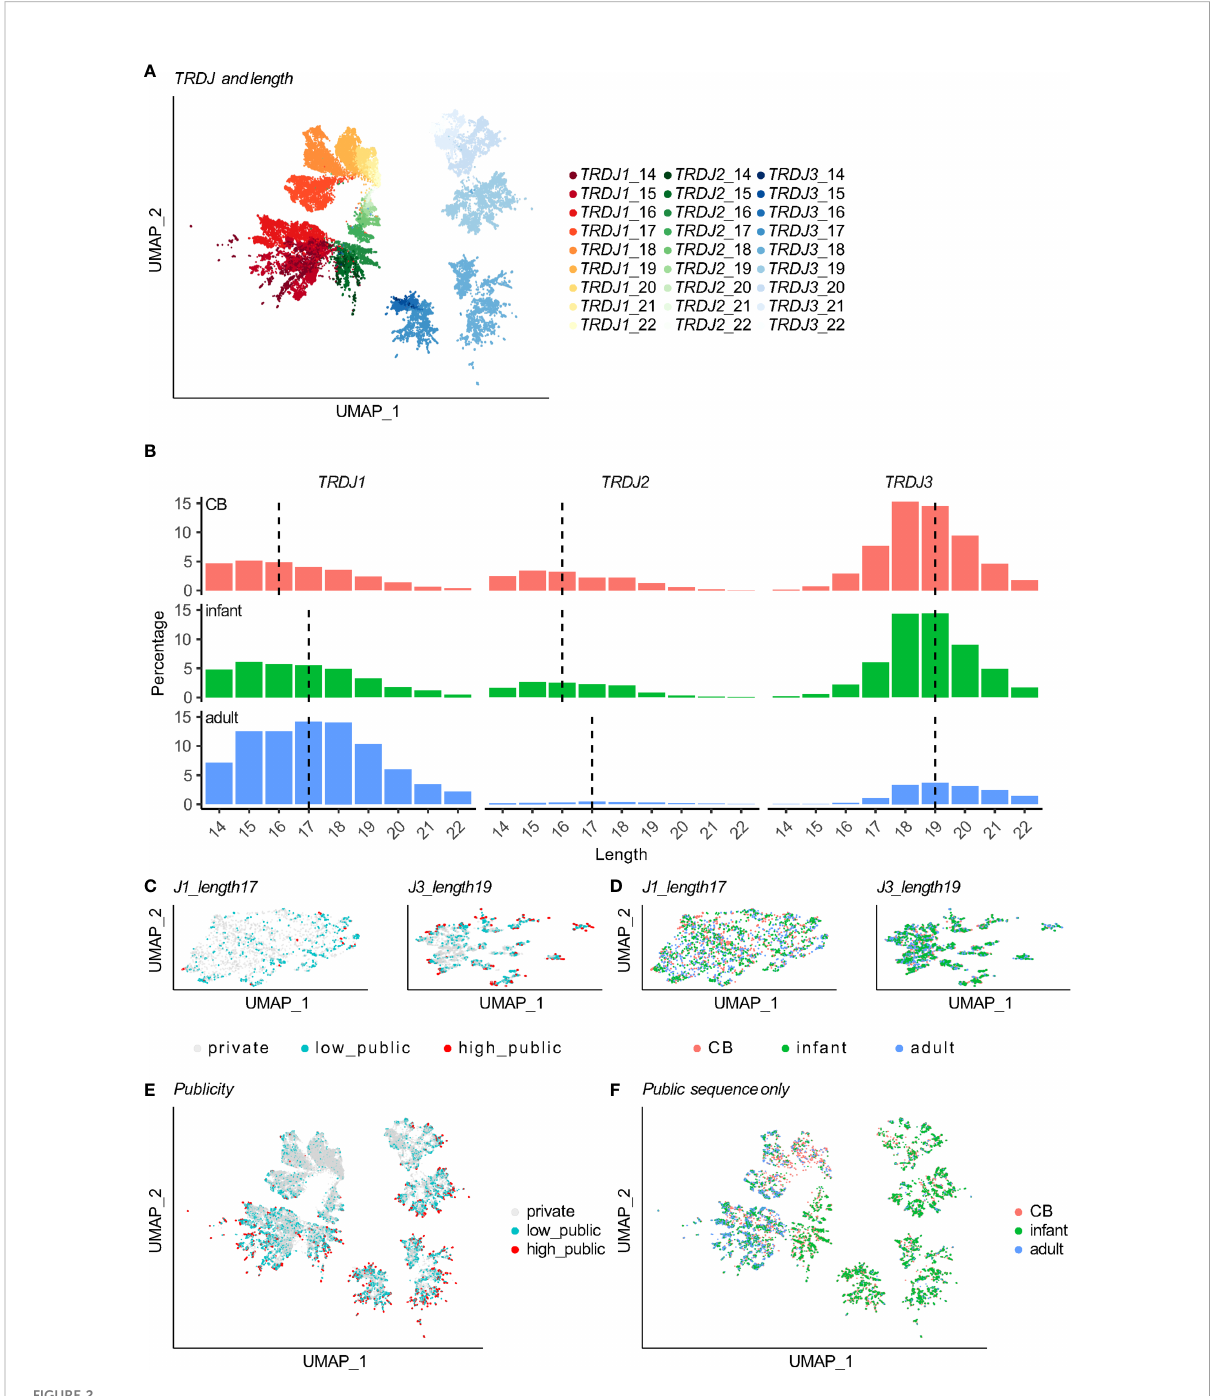
FIGURE 2 The heterogeneity of V d 2 TCRs is determined by CDR3 lengths and TRDJ segments. (A) Each point stands for a V d 2 + CDR3aa sequence. UMAP for 52,199 V d 2 + CDR3 (same data as in Figure 1B) colored by the combination of J gene usage and CDR3aa length. (B) CDR3aa length distribution with different J segments and age groups. The dashed line indicates the median length. (C) UMAP of length = 17 TRDJ1 V d 2 + CDR3aa sequences (left), UMAP of length = 19 TRDJ3 V d 2 + CDR3aa sequences (right) colored by sequence publicity. (D) The same UMAPs in (C) are colored by age group. (E) Same UMAP in (A) colored by the publicity label of the sequence. (F) UMAP in (A) after fi ltering out private TCRs, colored by age